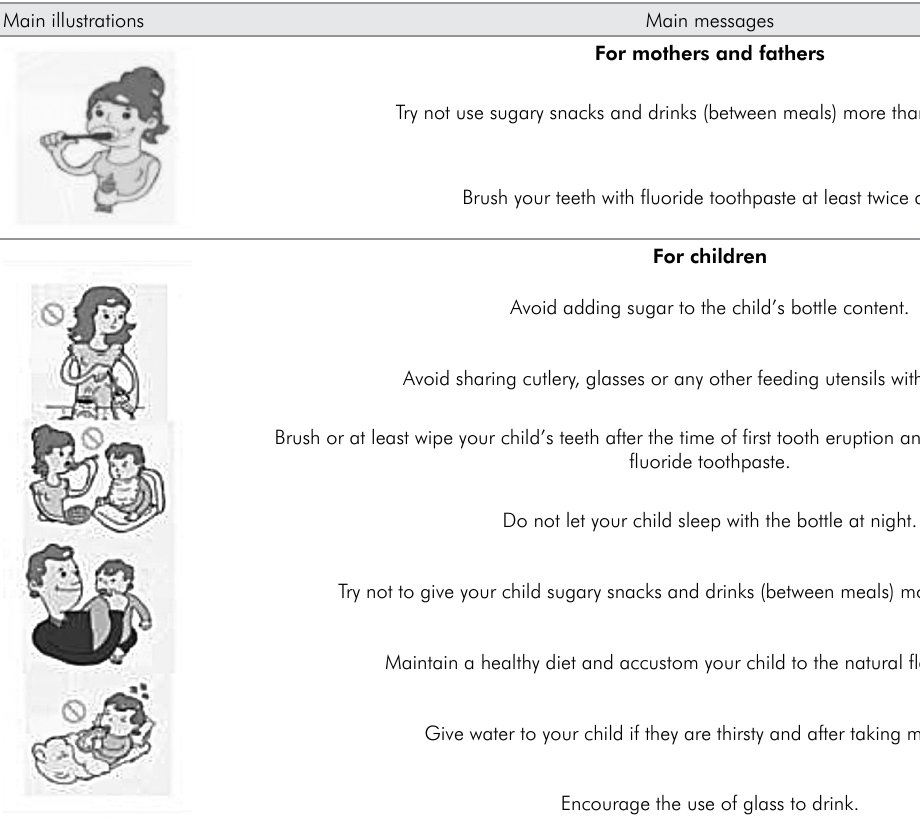
Figure. The main messages and illustrations of the pamphlet used to prevent early childhood